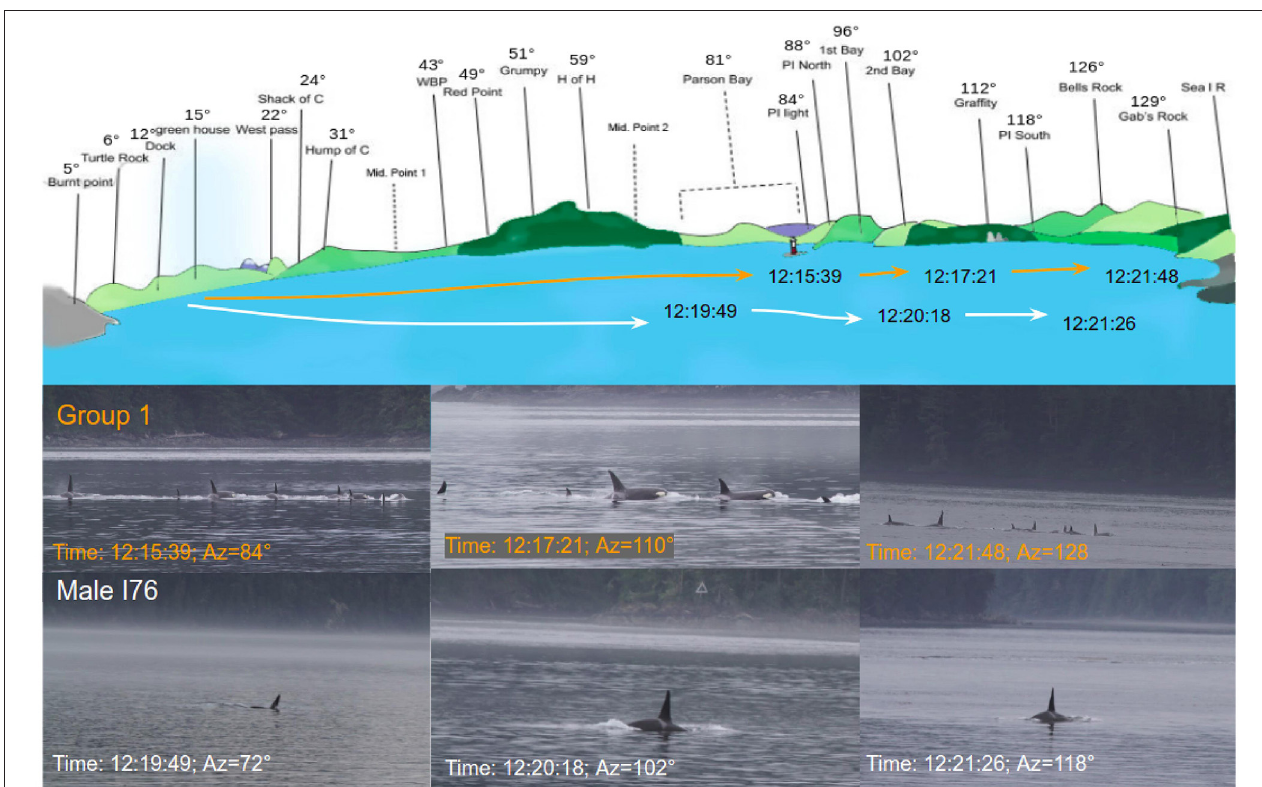
FIGURE 11 | Graph of the passage of the 31st of August. Top: representation of the view of Blackney Pass from Orcalab with the visual position of the group (orange) and the male I76 (white). Bottom: pictures taken from